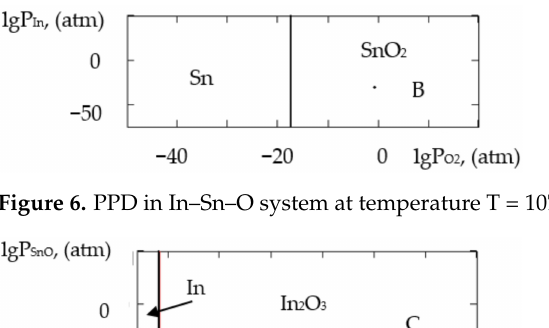
Figure 5. PPD in In–Sn–O system at temperature T = 873 K within lgP O2 –lgP In .